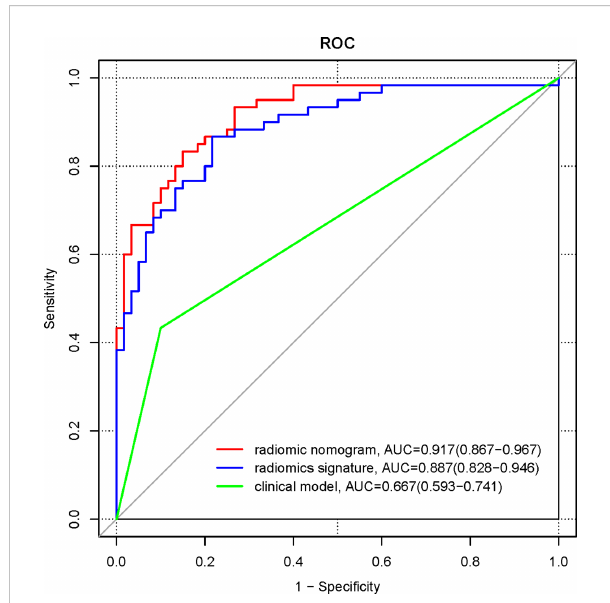
FIGURE 6 ROC curves for clinical model, radiomics signature, and radiomics nomogram in the pooled population.